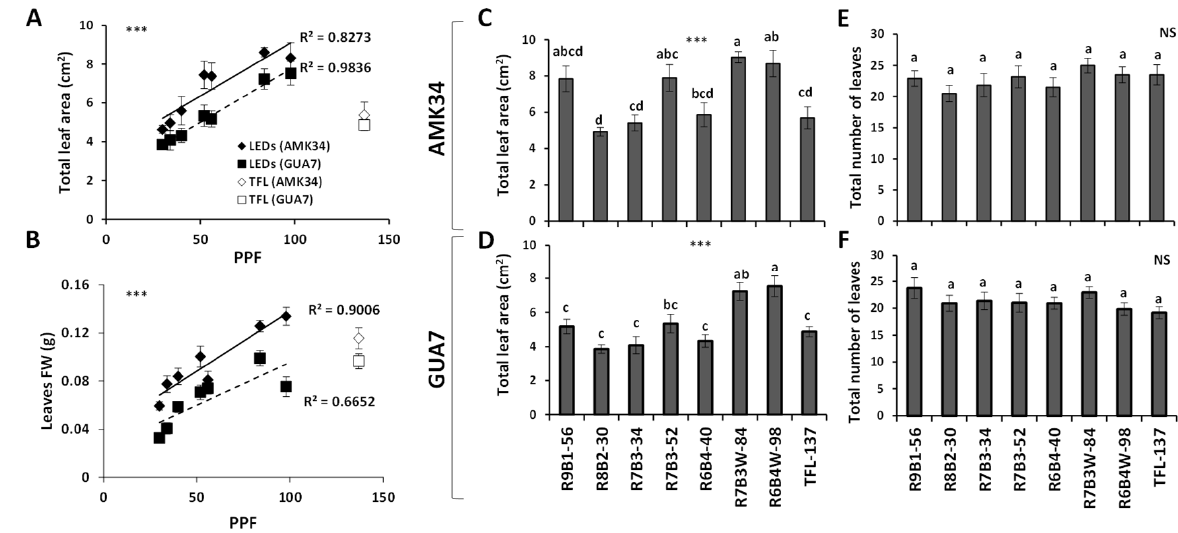
Figure 4. Effect of illumination quality and quantity on leaf area and leaf fresh weight. Correlation of light intensity with the leaf area in the AMK34 and GUA7 olive genotypes ( A ). Correlation of light intensity with the leaf fresh weight in the AMK34 and GUA7 olive genotypes ( B ). Effect of different illumination regimes from light-emitting diodes (LEDs) and fluorescent lighting (TFL-137) on the total leaf area of AMK34 ( C ) and GUA7 ( D ) plants. Effects of different illumination regimes from light-emitting diodes (LEDs) and fluorescent lighting (TFL-137) on the total number of leaves in AMK34 ( E ) and GUA7 ( F ) plants. PPF, photosynthetic photon flux. Levels of significance: *** p ≤ 0.001; and non-significant (NS).